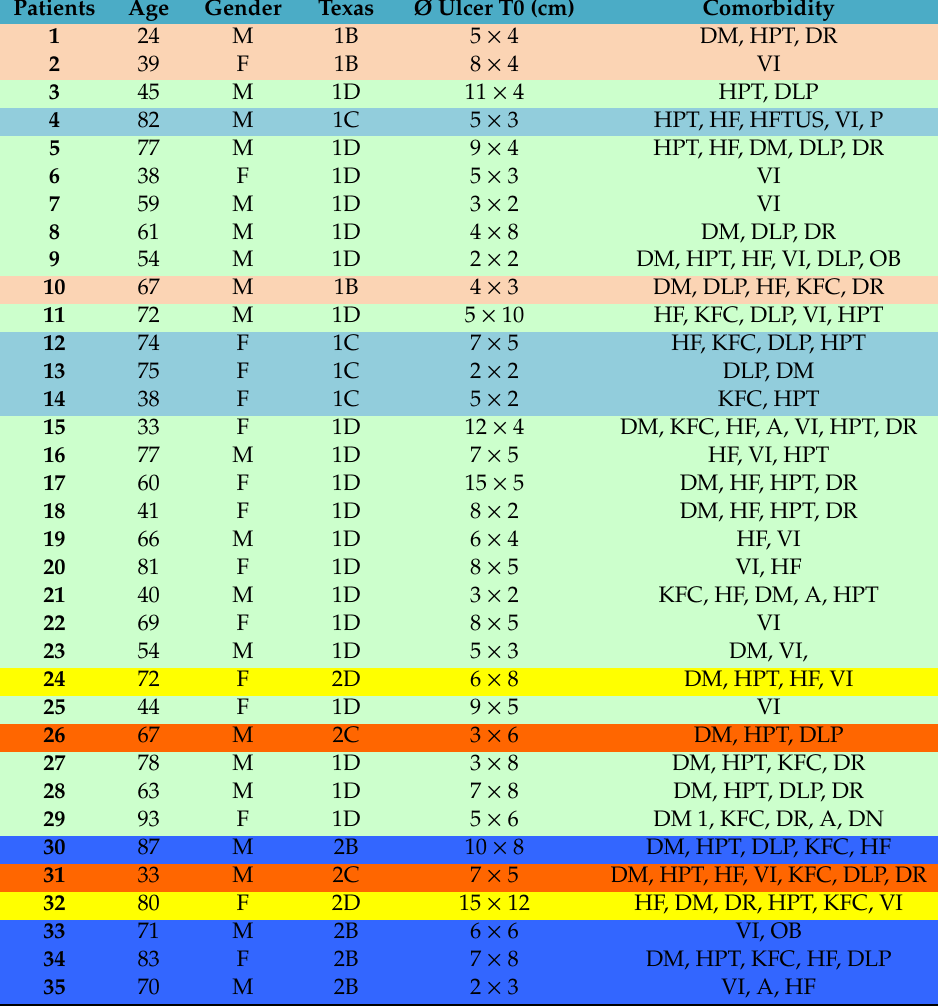
Table 1. Patient’s characteristics with the comorbidity, Texas scale grade and dimensions of the ulcers. Abbreviations: Diameter (Ø), Centimeters (cm), Anemia (A), Dyslipidemia (DLP), Diabetes Mellitus (DM), Hemodialysis (HD), Liver Failure (LF), Hypertension (HPT), Heart Failure (HF), Respiratory Failure (RF), Kidney Failure (KF), Vascular Insu ffi ciency (VI), Diabetic Neuropathy (DN), Obesity (OB), Diabetic Retinopathy